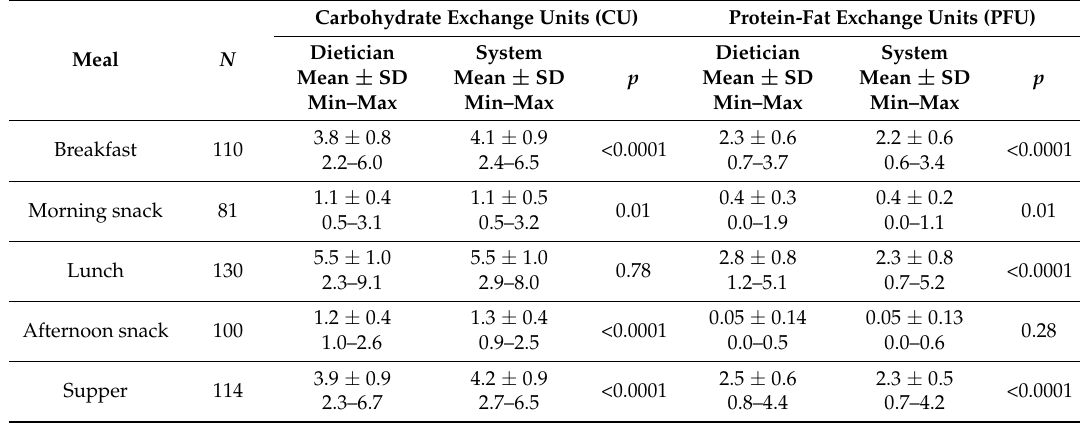
Table 2. Carbohydrate exchange unit (CU) and the protein–fat exchange unit (PFU) counting by the dietician and the VoiceDiab